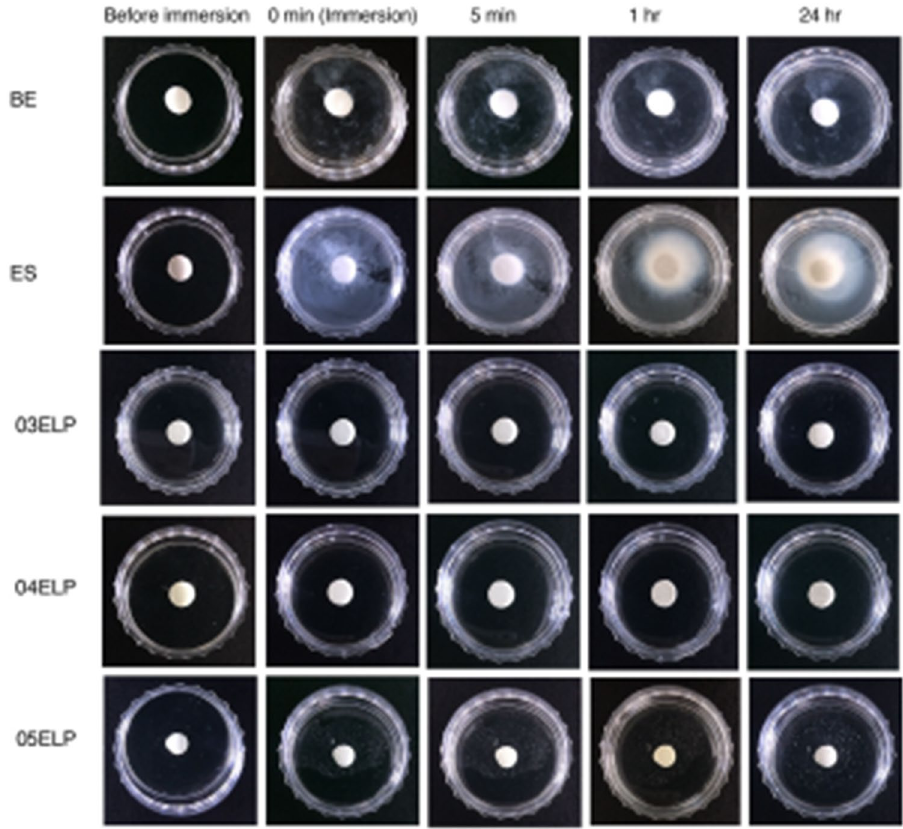
Figure 5. Evaluation of washout resistance. Groups 03ELP and 04ELP show distinct washout resistance than the other groups. ES demonstrates the least washout resistance among